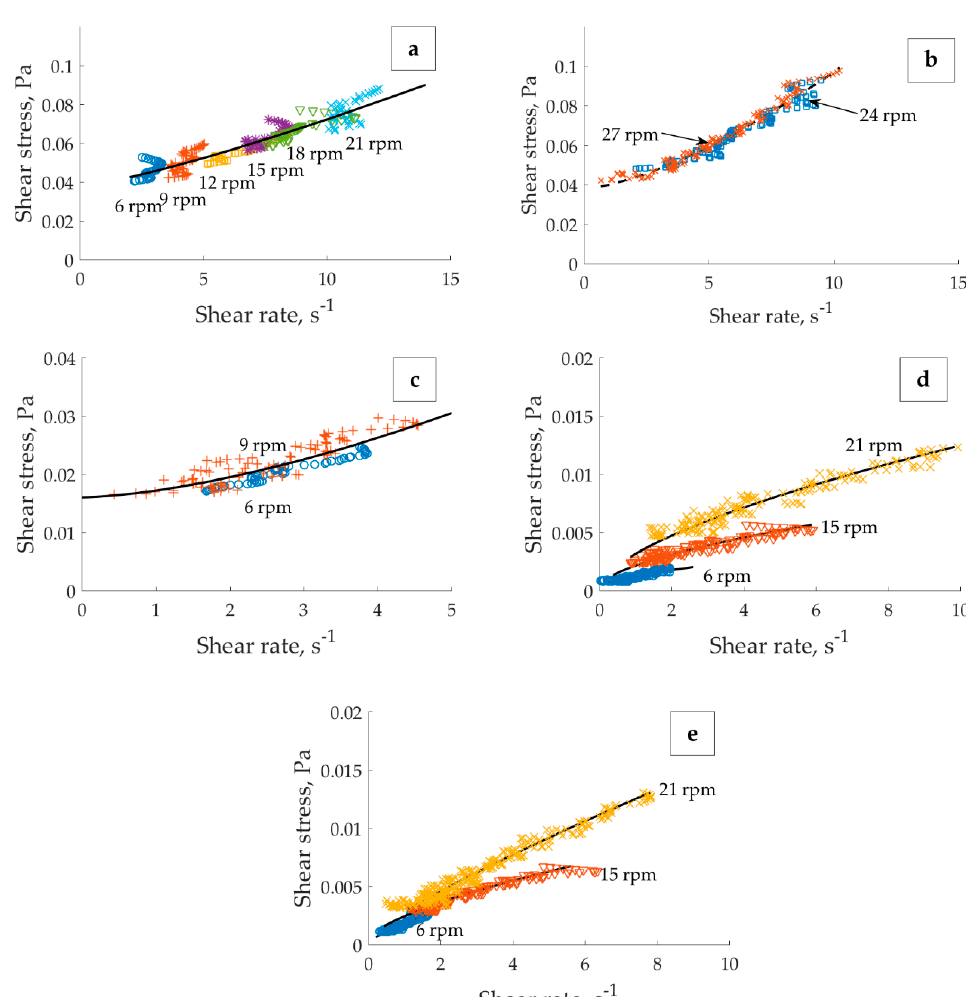
Figure 11. Local rheology (calculated from MRI velocimetry) for suspensions prepared under different chemistry, with Herschel–Bulkley fit for: ( a ) pH 4 in 1 × 10 − 2 M KNO 3 , 6–21 rpm (solid line: K = 0.002 Pa · s, n = 1.24, τ 0 = 0.038 Pa); ( b ) pH 4 in 1 × 10 − 2 M KNO 3 , 24, 27 rpm (dashed line: K = 0.002 Pa · s, n = 1.47, τ 0 = 0.038 Pa); ( c ) pH 4 in 1 × 10 − 2 M NaCl (solid line, K = 0.0012 Pa · s, n = 1.56, τ 0 = 0.016 Pa); ( d ) pH 8 in 1 × 10 − 2 M KNO 3 , ( e ) pH 10 1 × 10 − 2 M KNO 3 .